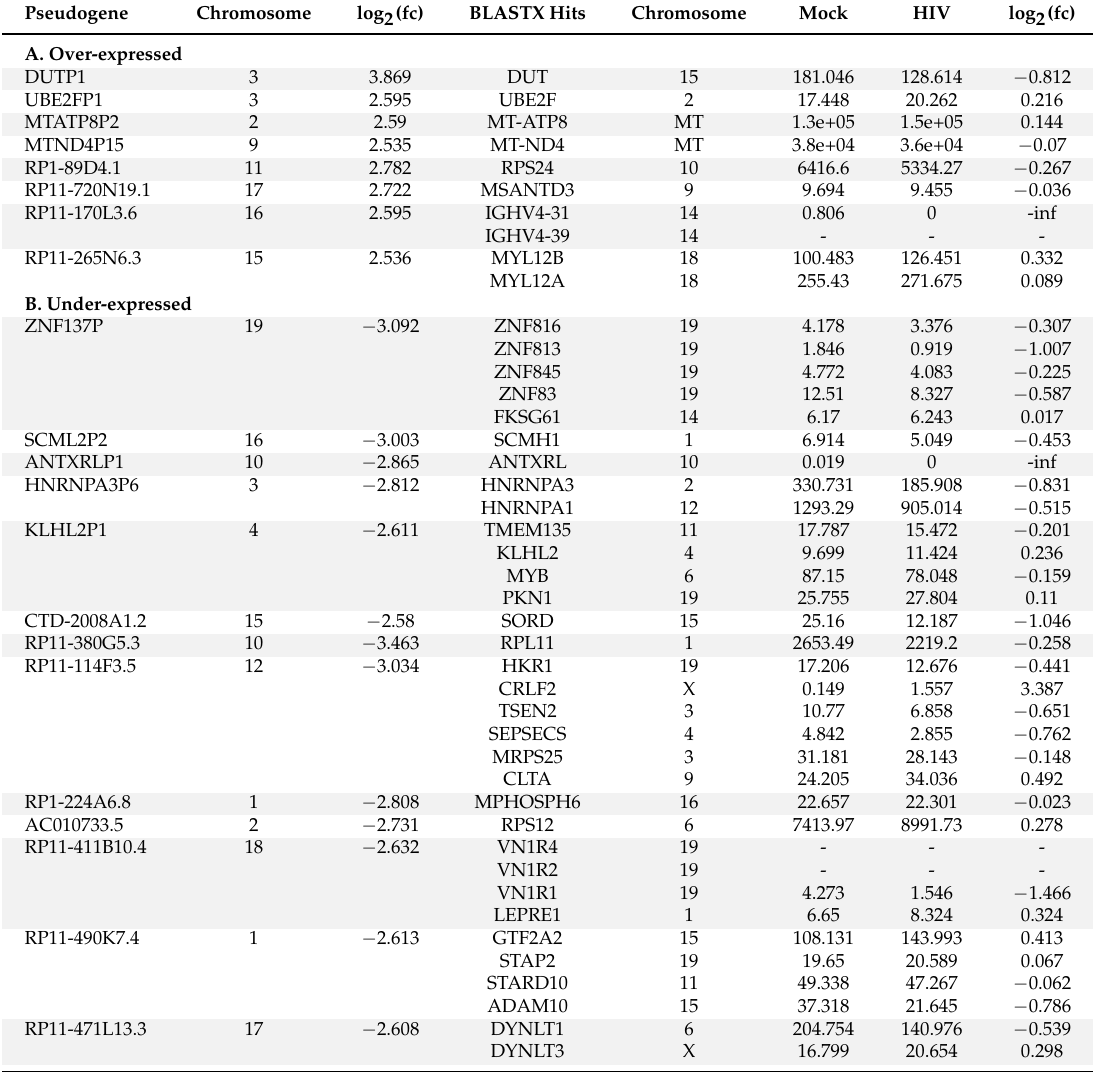
Table 2. BLASTX hits of differentially-expressed pseudogenes. Only hits to known protein-coding genes with E-value < 10 − 4 are shown. “fc” denotes fold change in gene expression; “Mock” represents gene expression in uninfected T-cells; and “HIV” denotes gene expression in HIV-1-infected T-cells 7 days